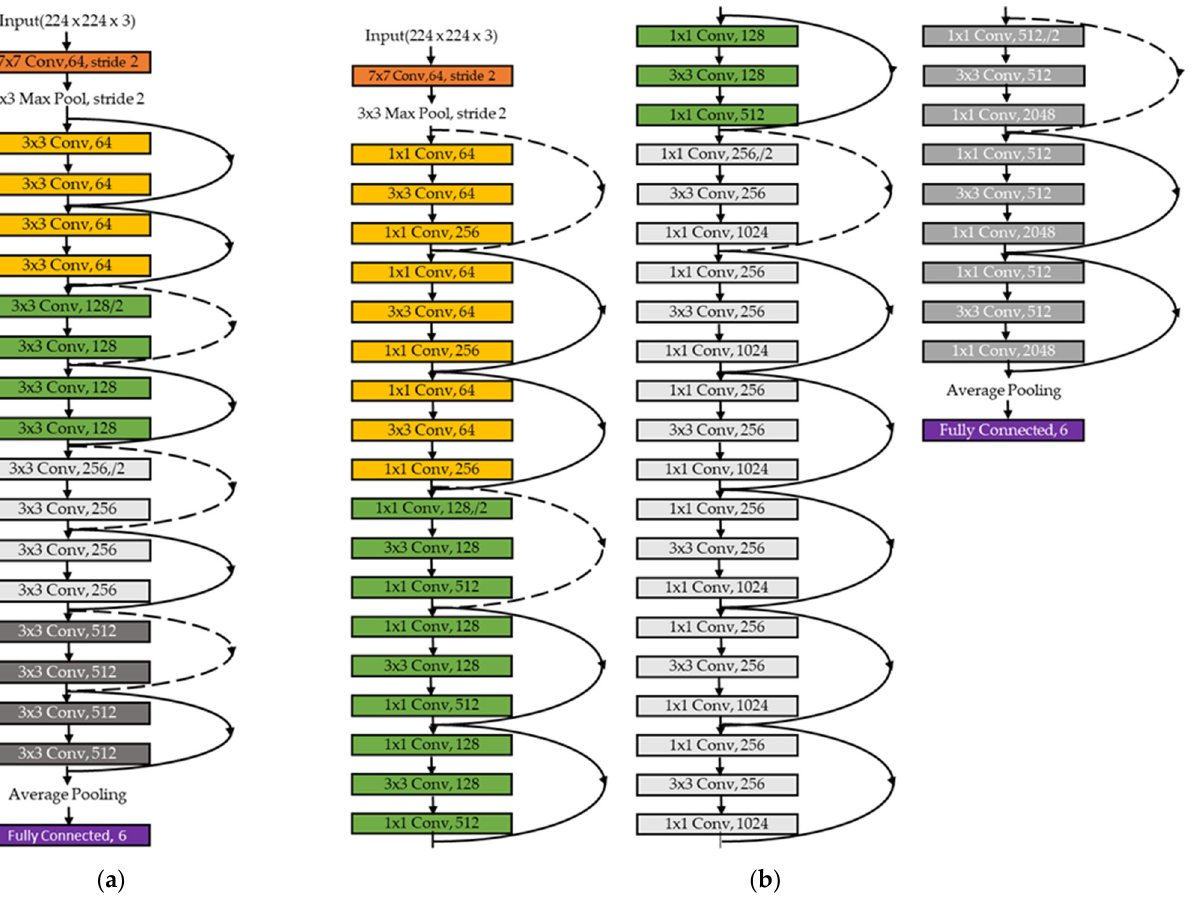
Figure 4. Architecture of the two adopted CNNs: ( a ) ResNet-18; ( b ) ResNet-50. Table 2. The structure of the two ResNet architectures that we used in this study. The two models comprised 18 and 50